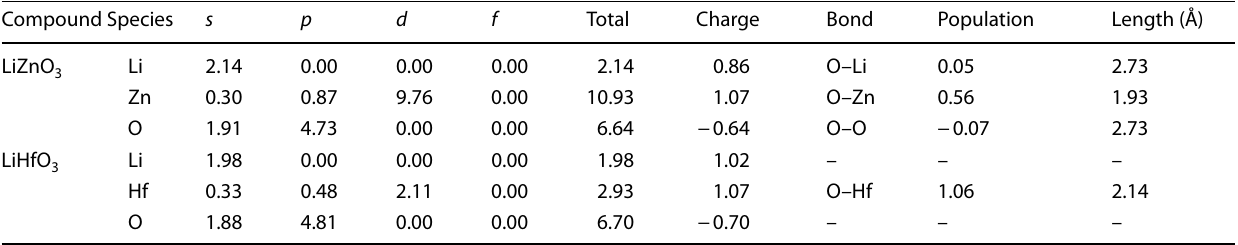
and LiZnO compounds Mulliken populations values Table 2 LiHfO 3 3 Compound